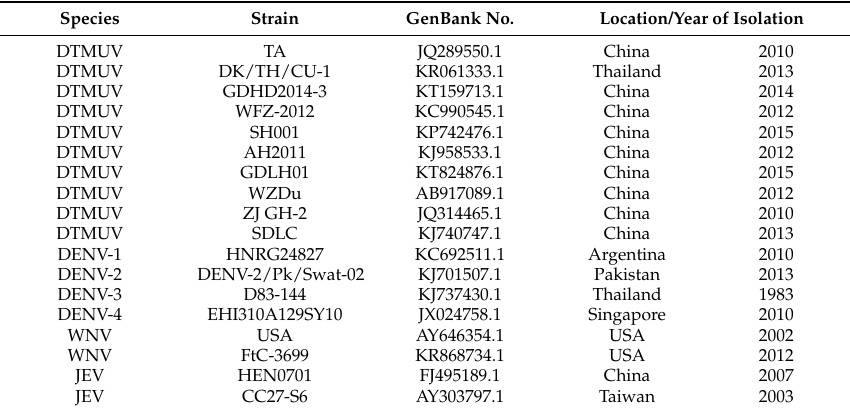
Table 3. Flavivirus strains used in the sequence analysis in this study.